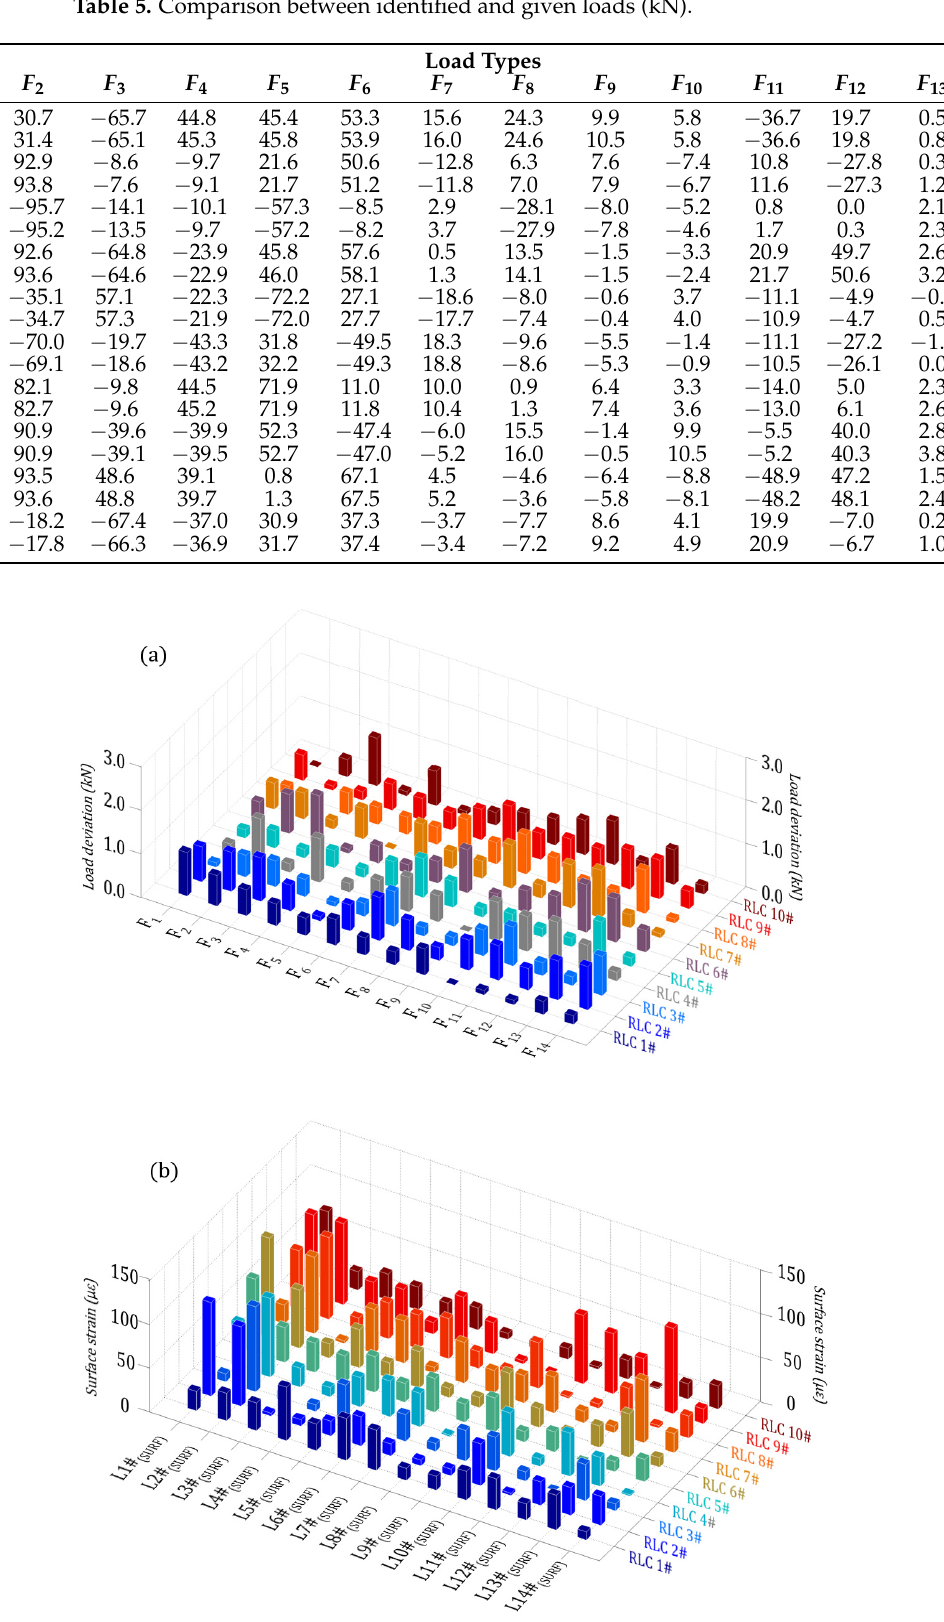
Figure 6. Contour bar plot of the validation result. ( a ) Difference between the identified and given loads; ( b ) surface strain.